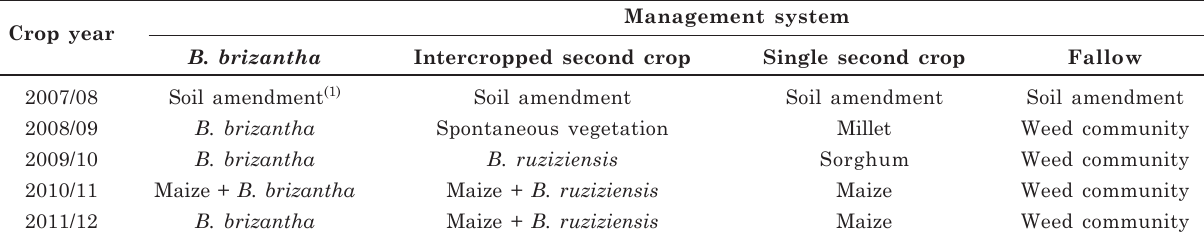
Table 2. History of management in the between-crop season of soybean cultivation in a dystrophic Red